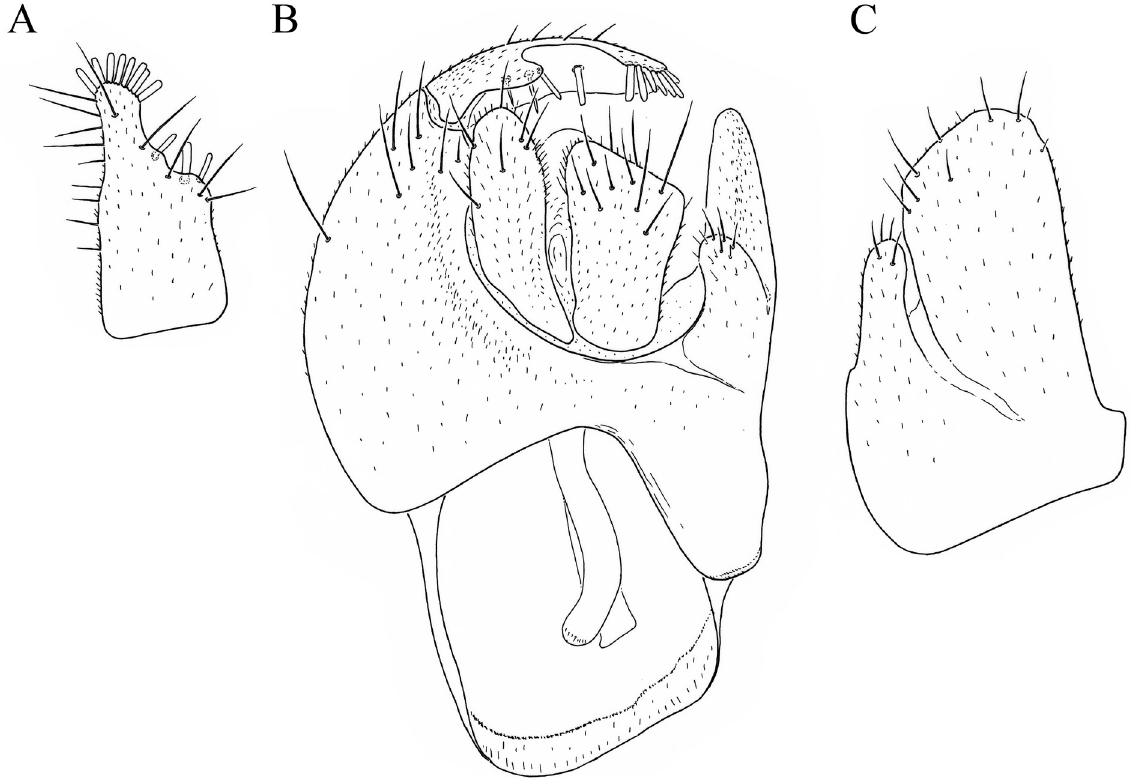
Fig. 9. Terminalia of the holotype of Tachydromia lusitanica (Grootaert, Shamshev & Andrade, 2009) from Portugal, Braga, Gilmonde (RBINS). A . Right surstylus. B . Epandrium with cerci. C . Left epandrial lamella and left surstylus. Figure adapted from Grootaert et al .